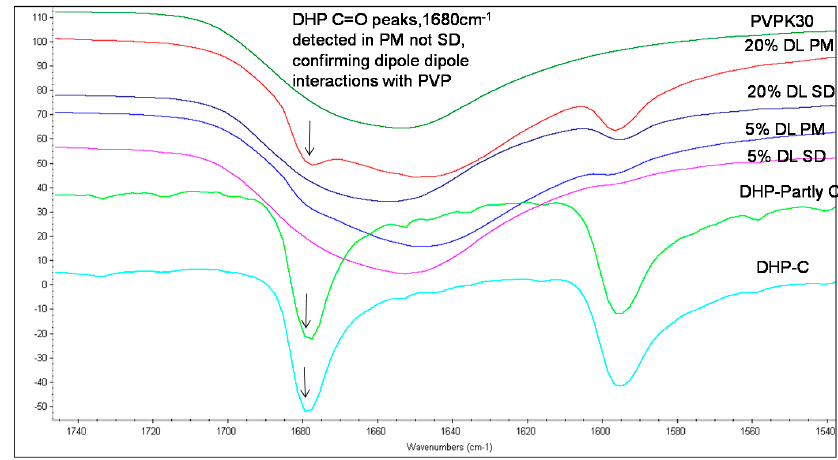
Figure 6. FTIR spectra of DHP PVPK30 solid dispersion (SD) and physical mixture (PM) showing -C=O stretching region at 1680 cm − 1 in crystalline (C), partly crystalline and physical mixture, which shifts in solid dispersion.